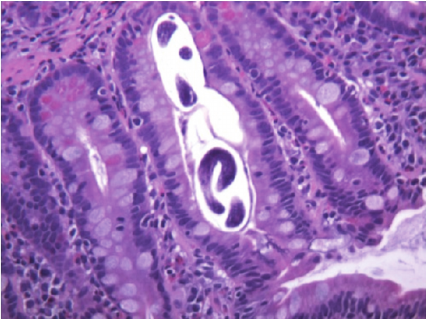
Figure 1: Duodenal mucosa showing adult worms of Strongy- loides stercoralis associated with chronic duodenitis and increased eosinophils (Hematoxylin and eosin stain, high power field